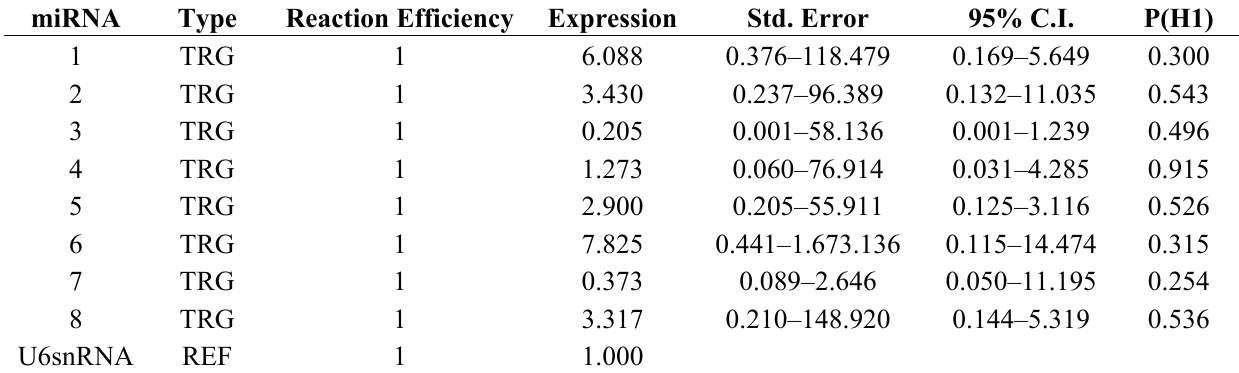
Figure 1. Relative expression (concentration) of the miRNAs analyzed in this study in samples frozen for 12 months compared with fresh samples. 1 = miR-125b-5p; 2 = miR-425-5p; 3 = miR-200b-5p; 4 = miR-200c-3p; 5 = miR-579-3p; 6 = miR-212-3p; 7 = miR-126-3p; 8 = miR-21-5p. Table 2. Relative expression (concentration), standard error, 95% confidence interval (C.I.), and p -value of miRNAs analyzed in this study (samples collected in 2010 and stored at − 80 °C compared with fresh samples). p -value ( ≥ 0.05) shows that there are no significant